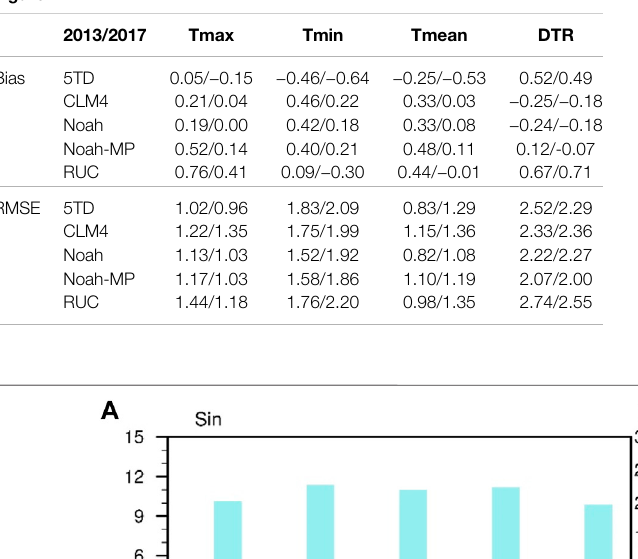
TABLE 2 | Statistics for the mean biases and RMSE for the spatially averaged temperature ( ° C) and DTR ( ° C) from the model simulations against the observational data for the 2013 and 2017 cases. The study regions are outlined in Figure 2 .